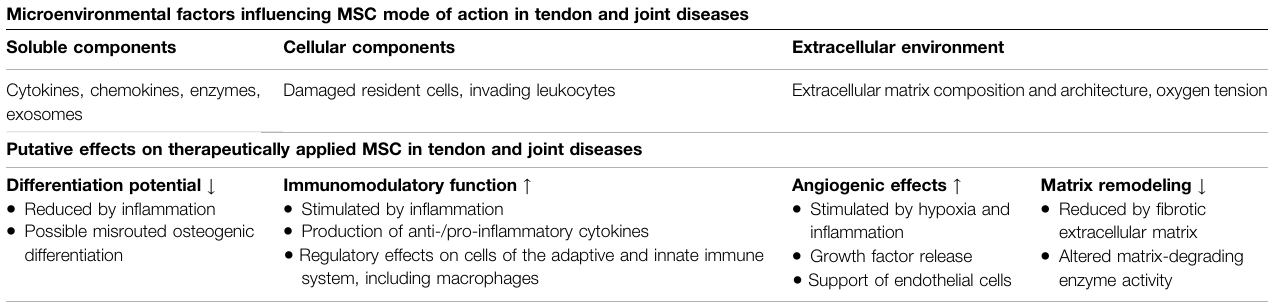
TABLE 1 | Overview of microenvironmental factors and their effect on MSC potential mechanisms of action in tendon and joint disease. Microenvironmental factors in fl uencing MSC mode of action in tendon and joint diseases Soluble